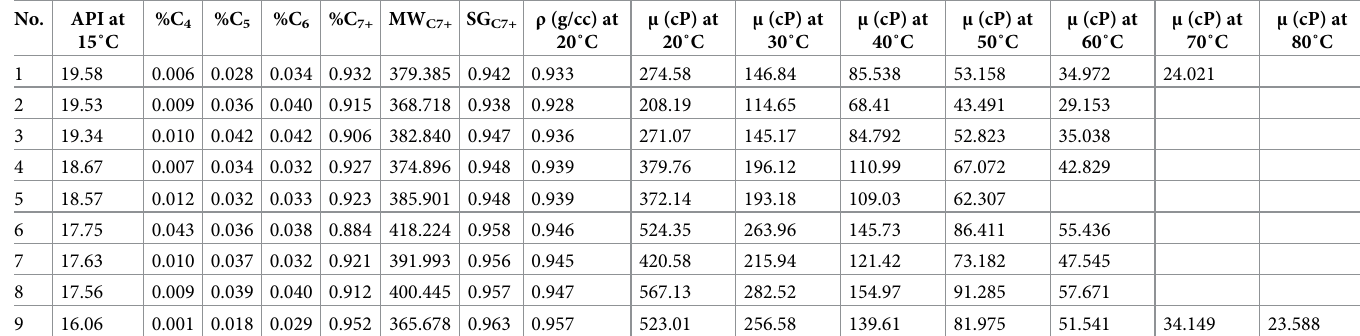
Table 2. The whole test dataset